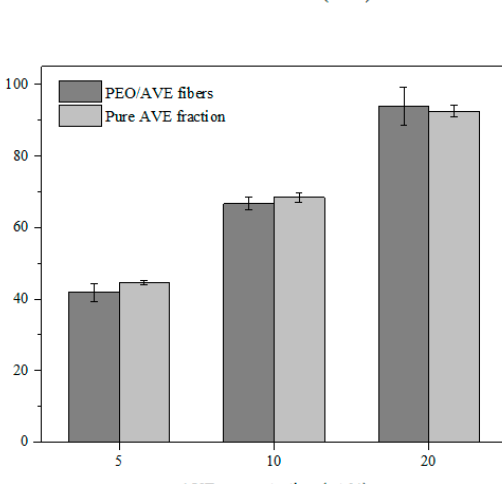
Figure 6. Antioxidant activity of PEO / AVE nanofibers and pure AVE fractions at t = 300 min. Error bars indicate standard deviation.